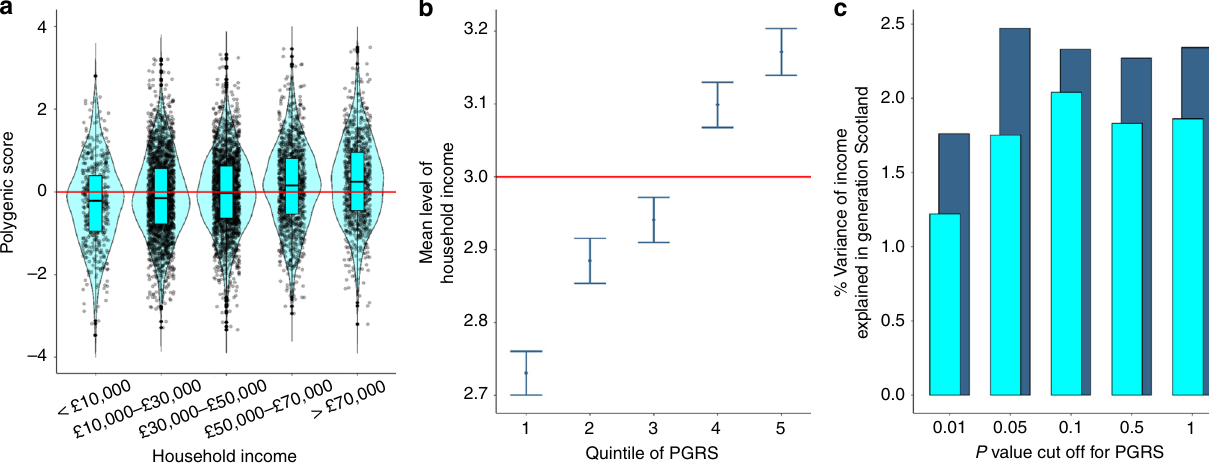
Fig. 7 Polygenic risk score analysis of income. a Violin plot showing the level of household income in GS:SFHS plotted against the standardized polygenic score of income in each group. Median and interquartile range are plotted. Summary data from the income GWAS performed in UK Biobank were used to derive PGRSs. Red line indicates a standardized polygenic score of 0. b The average level of household income for the fi ve PGRSs is shown. Summary data from the income GWAS performed in UK Biobank were used to derive PGRSs. The y -axis corresponds to the 5-point classi fi cation of household income in Generation Scotland. Above the red line indicates a level of household income between £30,000 and £50,000 and below indicates a level of household income between £10,000 and £30,000 in Generation Scotland. Error bars represent ± 1 SE. c The variance accounted for by each of the fi ve P value cutoffs for the PGRS. Light orange indicates that the income phenotype derived in UK Biobank was used to generate polygenic risk scores along with Generation Scotland. The dark orange bars indicate instances of where the MTAG phenotype derived using income and educational attainment was used to derive polygenic risk scores in Generation Scotland. Summary data from the income GWAS performed in UK Biobank, and the MTAG analysis of income was used to derive PGRSs. All results can be found in Supplementary Table